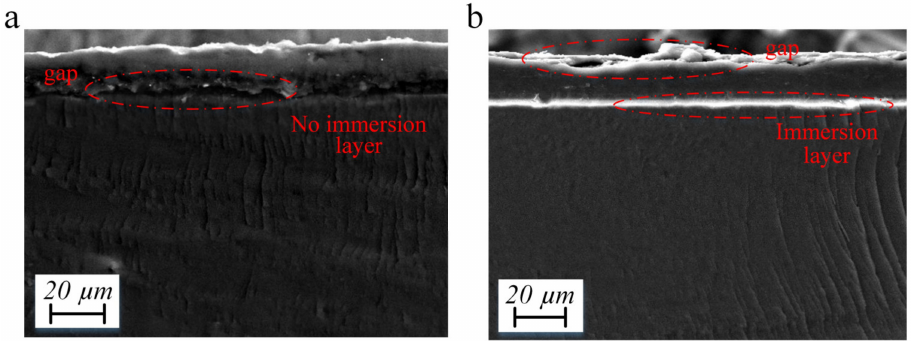
Figure 4. Characterization. ( a ) Cross-section of sample C3. ( b ) Cross-section of sample